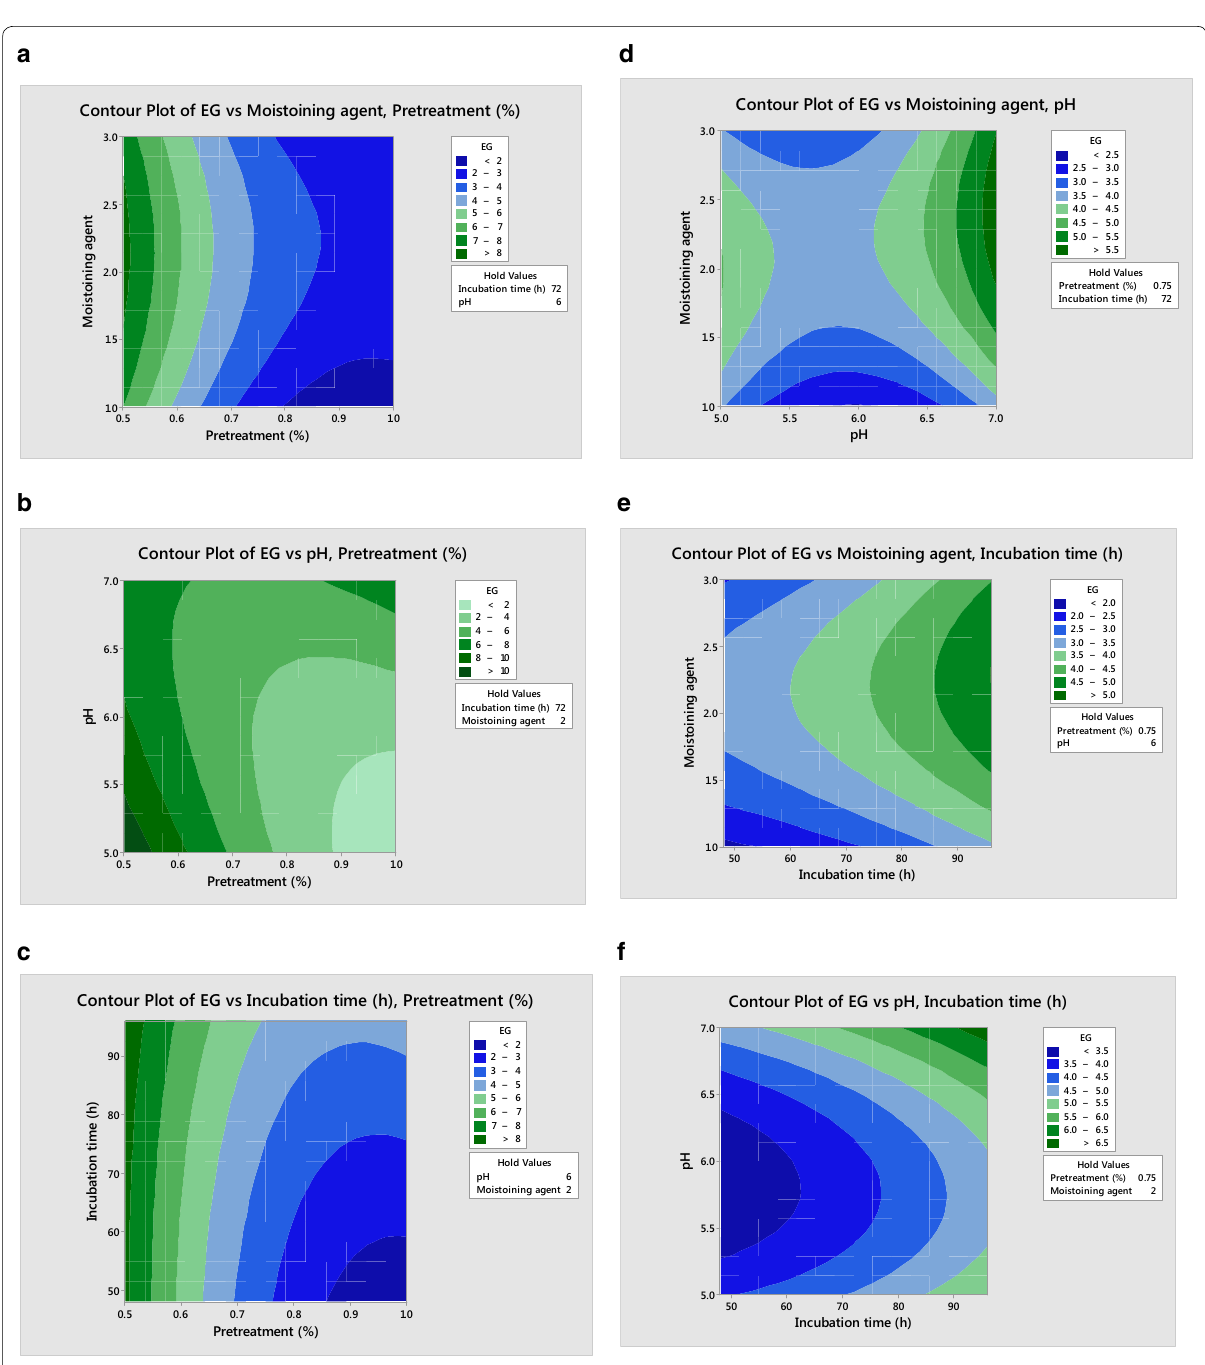
Fig. 1 Contour plots of EG showing interaction between: a moistening agent and pretreatment, b moistening agent’s pH and pretreatment, c incubation time and pretreatment, d moistening agent and its pH, e moistening agent and incubation time, and f moistening agent’s pH and incubation